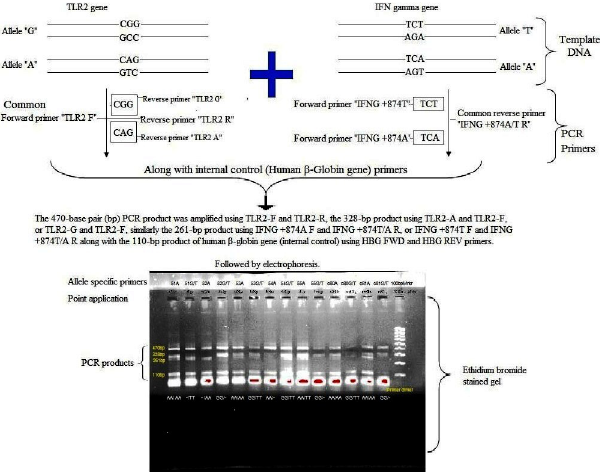
Fig 3. Amplification refractory mutation system-multi gene/ multi primer polymerase chain reaction (ARMS-MG/MP-PCR) method. ARMS-MG/MP-PCR method genotyping assay for detection of G to A nucleotide substitution for TLR2 and T to A substitution for IFN- γ gene. Results for the three possible genotypes (GG, AG and AA) for TLR2 and IFN- γ gene (TT, TA, AA) are shown above the PCR products. Three percent agarose gel electrophoresis was carried out with ARMS-MG/MP-PCR products: Lanes 51a to 55g were loaded with ARMS-MG/MP-PCR products of female genital tuberculosis (FGTB) patients. Lanes C80a to C81g was loaded with PCR products of healthy control women (HCW) without tuberculosis (TB). Lane 100 bp Mrkr was loaded with 100 base pair (bp) molecular weight marker (the 100bp size of product starts from the bottom side of the gel and ends with 1000 bp of product on the top/upper side of the gel). The upper bands symbolize the 470 bp internal control PCR fragment, the 328 bp bands represent the ‘ A ’ (lane 51a) and ‘ G ’ (lane 55g) alleles of TLR2 (Arg753Gln) gene. The 261 bp bands represent the ‘ A ’ (lane 51a) and ‘ T ’ (lane 55g) alleles of IFN- γ (+874) gene, and lower bands stands for the human β -globin gene (110 bp internal control). Primer dimers were also noted at the bottom, during the end of the sample